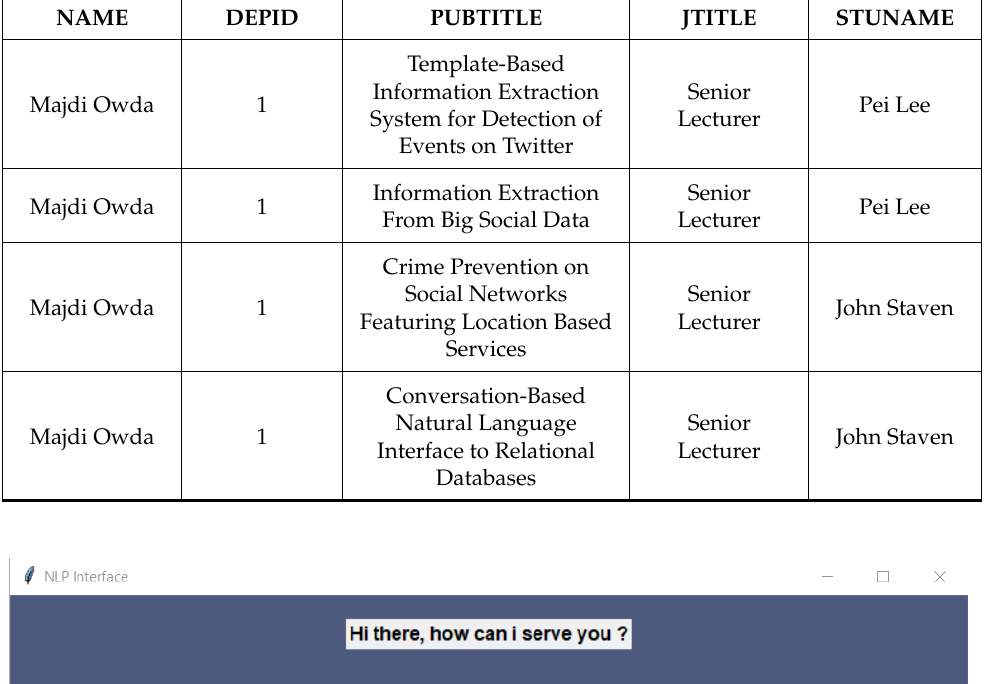
Table 2. Example (1): query dynamic screen results.